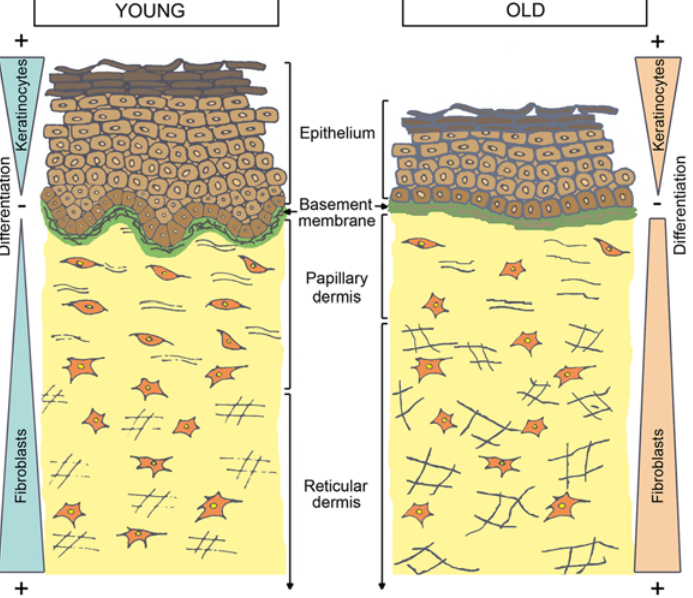
Figure 10. Model of skin morphogenesis and aging. Preferential modifications of Fp characteristics throughout aging may have structural and physiological consequences not only on the dermis, but also on the epidermis. Cellular differentiation of epidermal keratinocytes and dermal fibroblasts may be symmetrically organized including upward differentiation of keratinocytes associated with downward differentiation of fibroblasts. This cellular organization may be altered during skin aging.